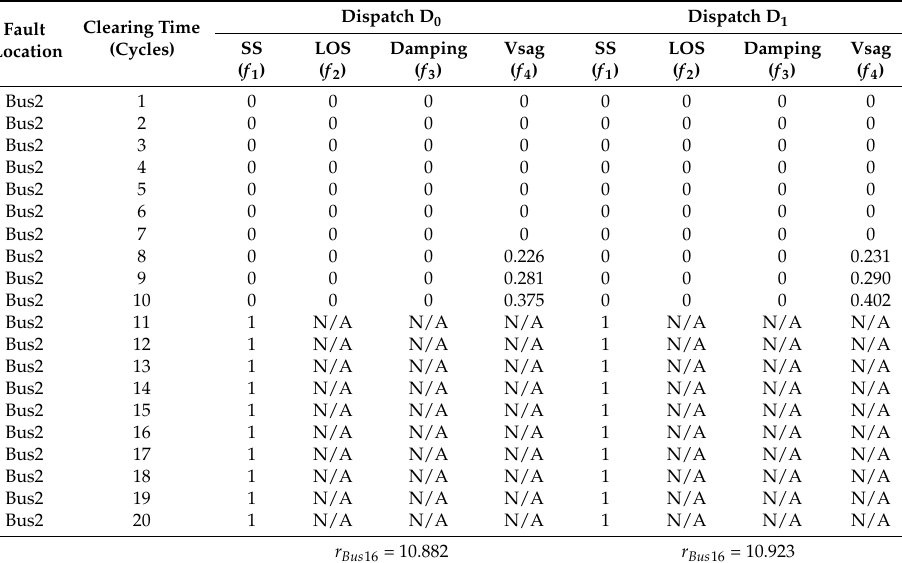
Figure 6. Voltage sags changes at bus 16. Table 3. Comparison of r Bus 16 value between dispatch D 0 and D 1 .